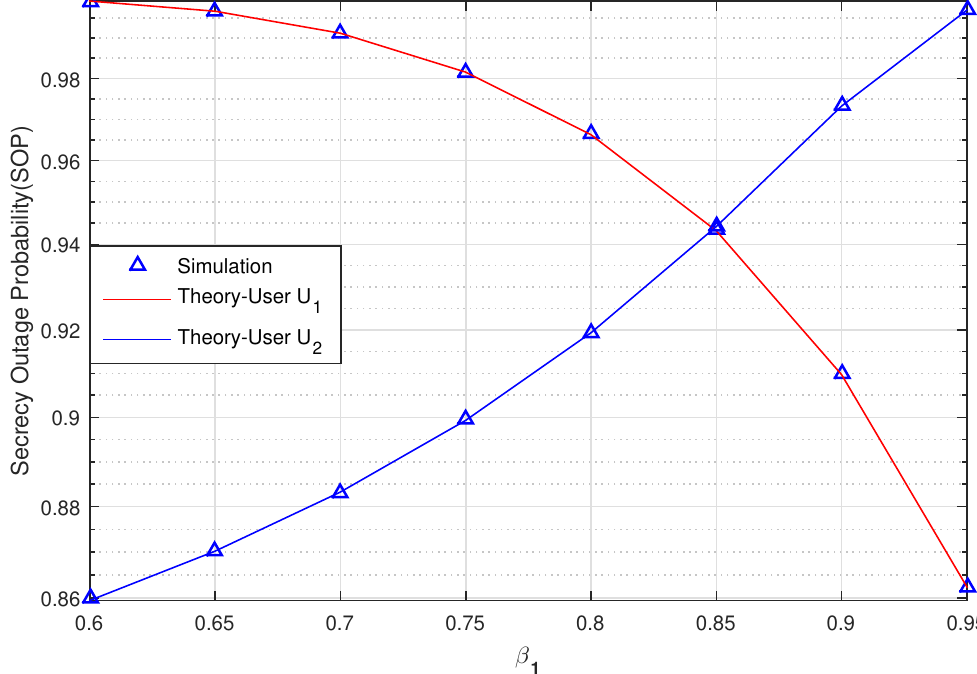
Figure 6. The SOP of U 1 and U 2 versus the power allocation coefficients β 1 when SNR = 10